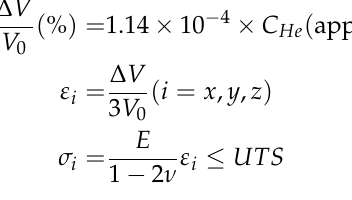
Table 2. The reaction yields of 1 H, 2 H and α for proton-accelerator and electron-accelerator neutron target. ParticlesLight Nuclides α LifetimeRatio of Light Nuclide Reaction Yields to That of the Generated Neutrons Incident